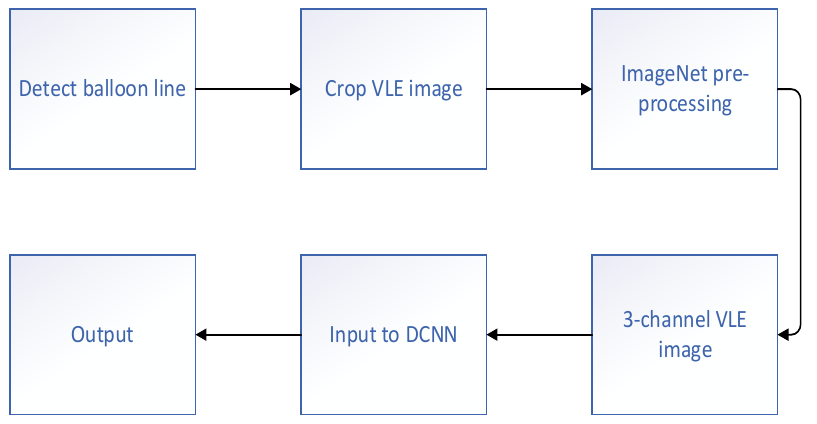
Figure 7. Framework of the method proposed by Fonollà et al. [38]. Table 3. Characteristics of models for the diagnosis of esophageal squamous cell carcinoma (ESCC) and esophageal adenocarcinoma (EAC) in the